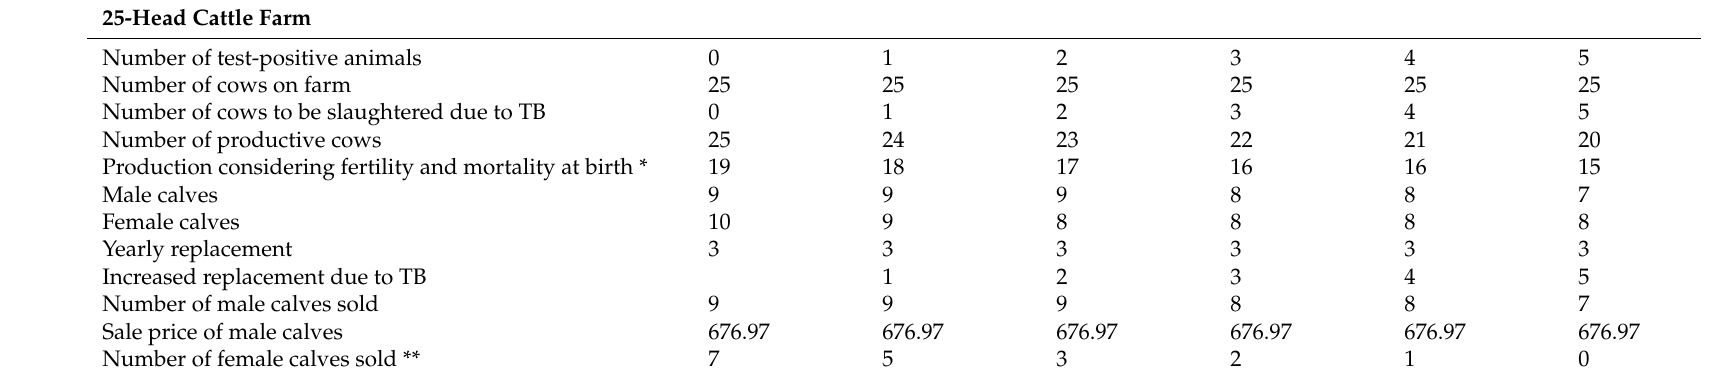
Table 5. Loss from replacement on a farm with 25 head of